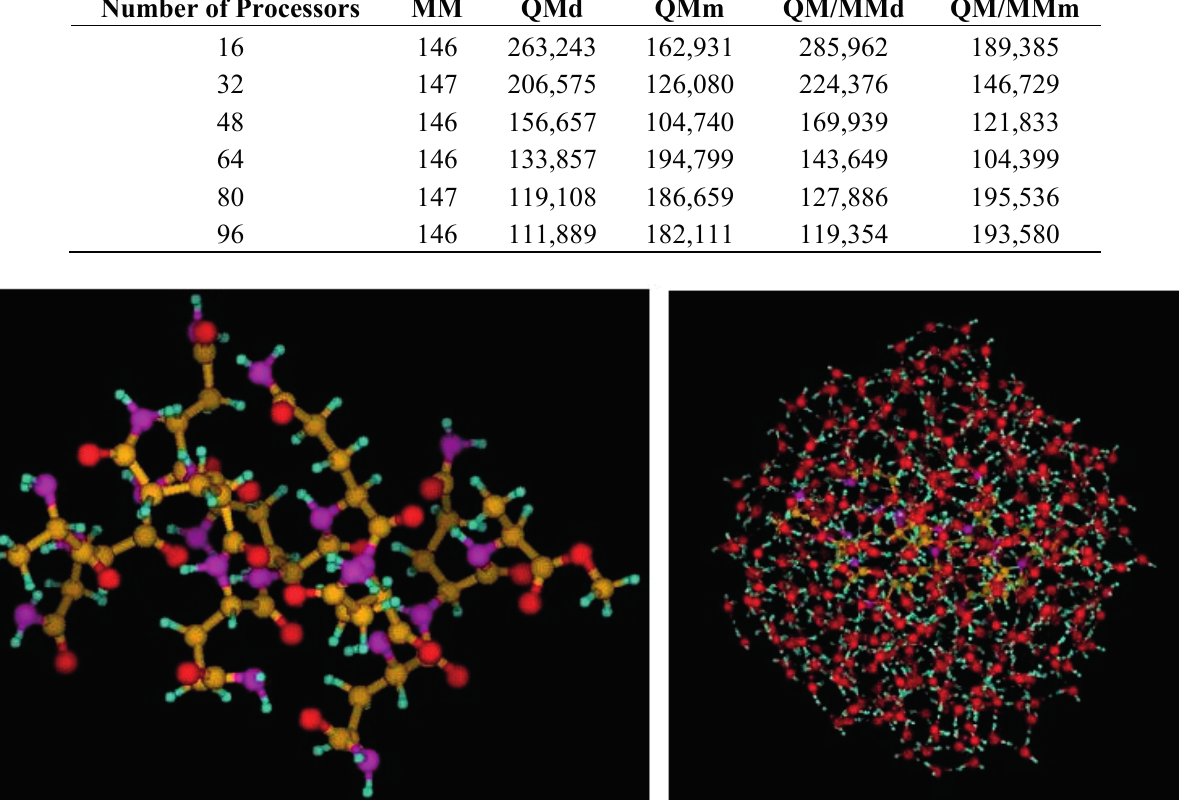
Figure 8. Structures of the A-Q9-A benchmark systems. On the left, the peptide with 179 QM atoms is depicted. On the right, the peptide dissolved in 440 MM waters is shown. Both structures are the starting points for the 1000 step MD runs discussed